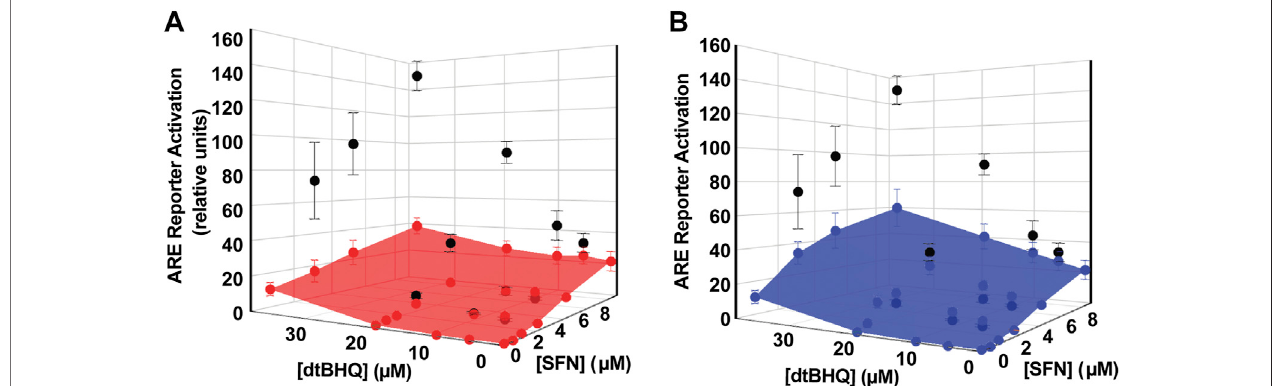
FIGURE 5 | Analysis of sulforaphane-dtBHQ dosing curves and combination treatment data by the DE/ZI method. The actual effects are shown in black and replotted from Figure 3C . DE/ZI predicted additive effects interpolated from the sulforaphane dosing curve are shown in (A) in red and in blue in (B) for those predicted using the dtBHQ dosing curve. Generation of the error bars for the predicted additive results is detailed in DE/ZI Analysis With the Script in R